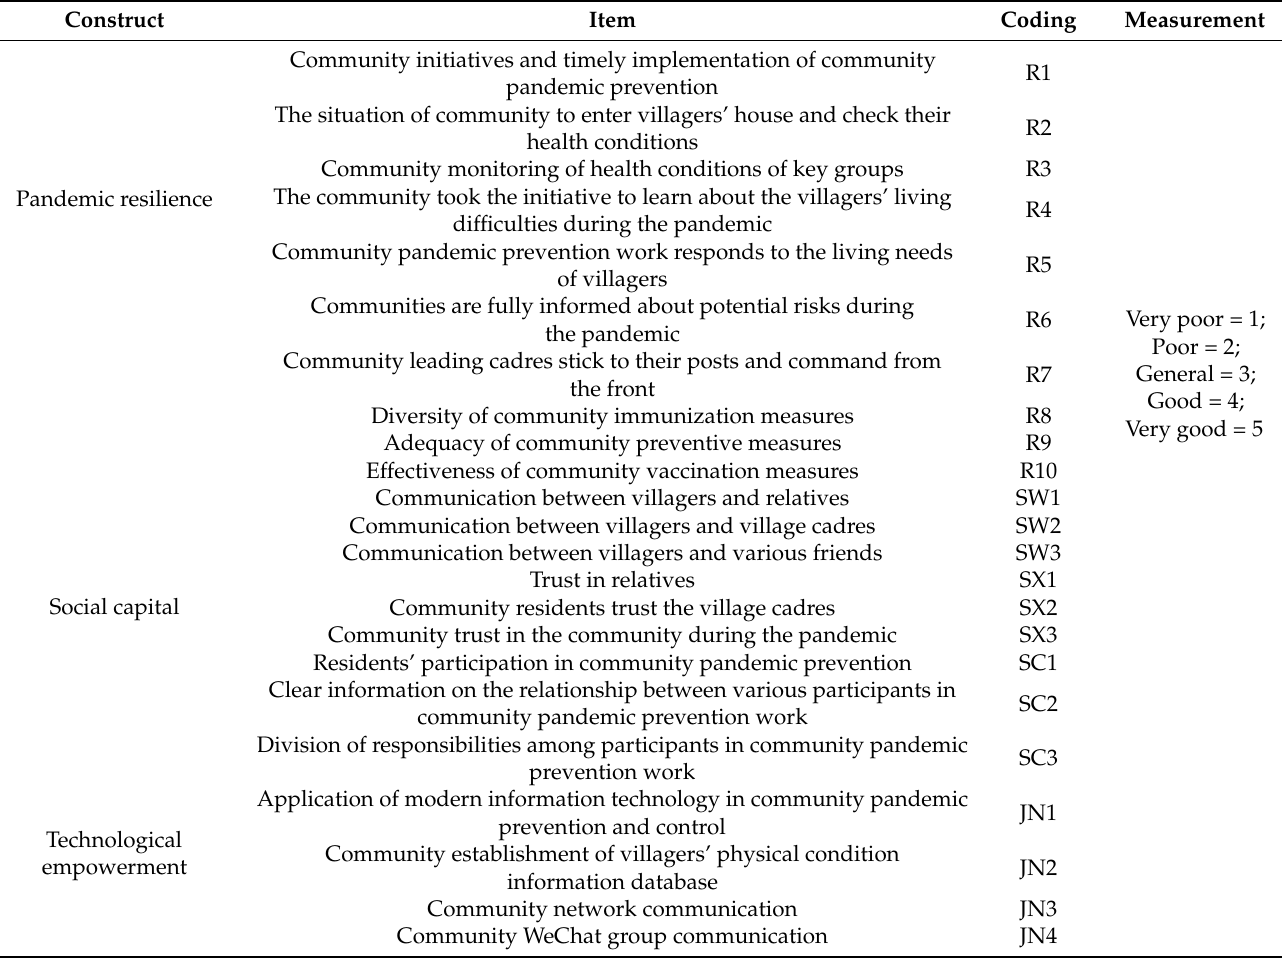
Table 3. Construct